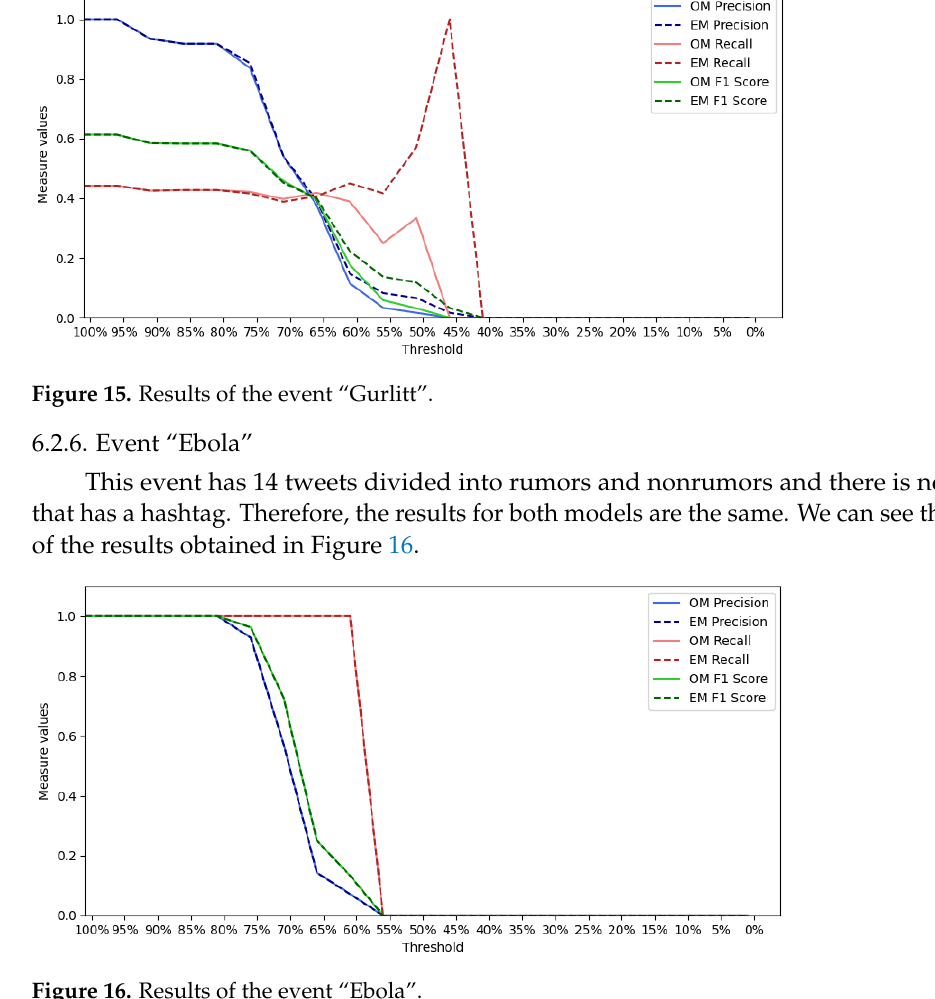
Figure 16. Results of the event